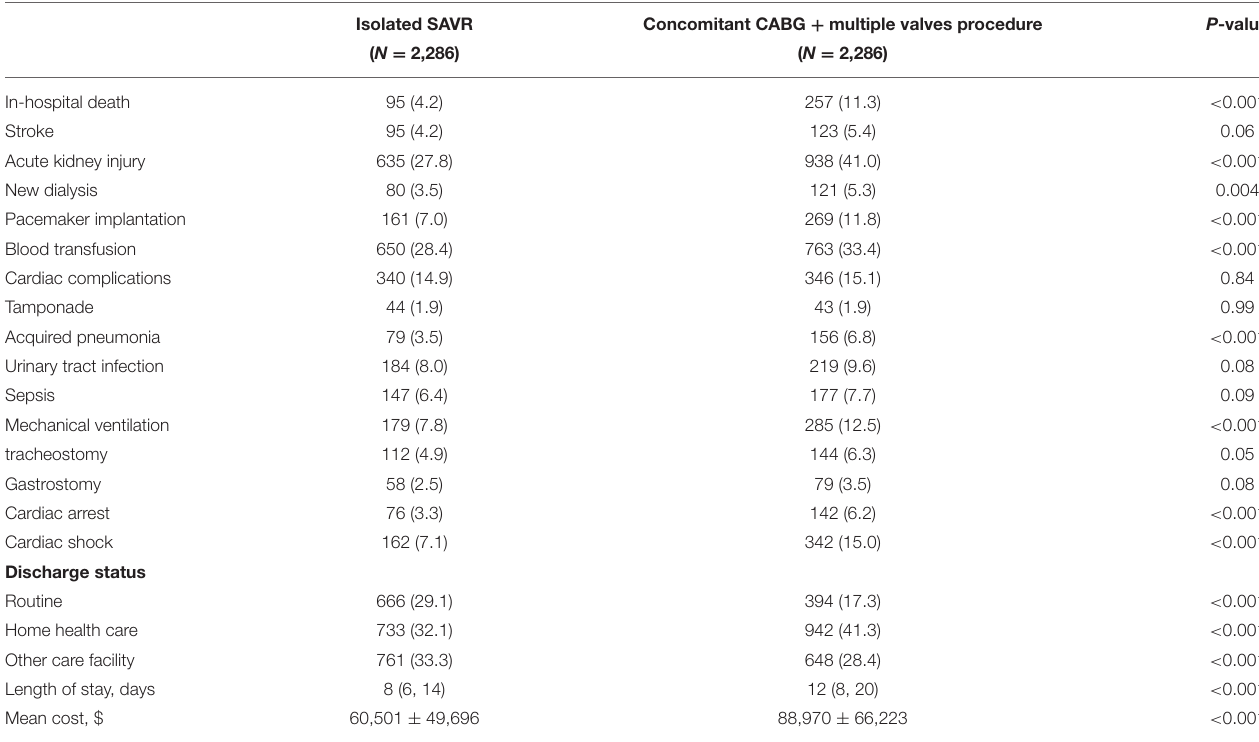
TABLE 5 | In-hospital Outcomes for isolated SAVR and SAVR with concomitant CABG + multiple valves procedure in the Propensity Matched